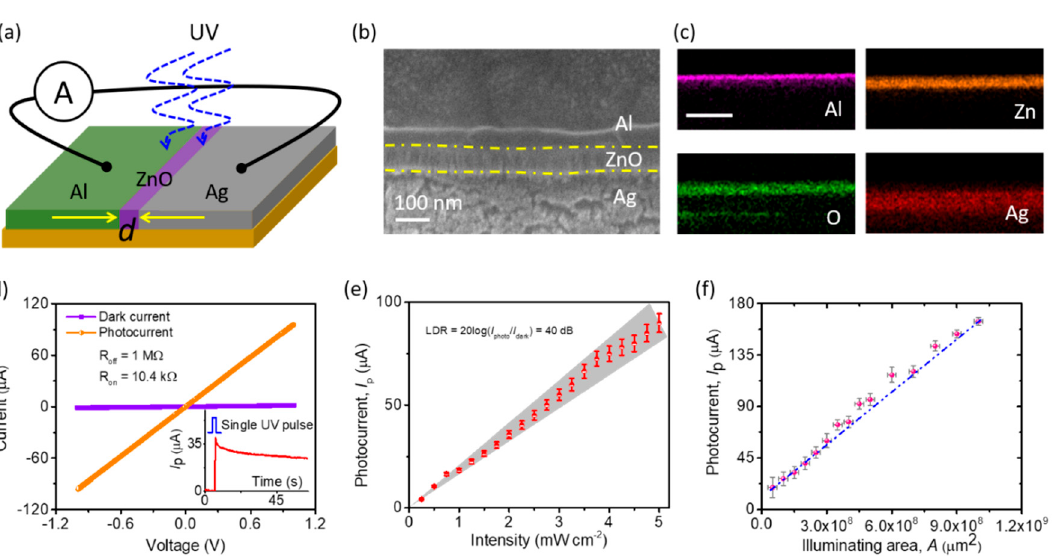
Figure 2. Schematic and device characterization. ( a ) Device schematic, ( b ) planar-view SEM of the ZnO nanofin sandwiched between Al and Ag thin film, ( c ) corresponding elemental distribution of the Al, Zn, O, and Ag from energy-dispersive X-ray spectroscopy (EDS) measurements, clockwise. The scale bar is 1 µ m. ( d ) Current–voltage characteristics of the device under dark and with di ff erent UV illumination, showing photocurrent generation. The inset of ( d ) shows the device retention measurements at + 0.6 V, after applying a single UV pulse. ( e ) The change in photocurrent ( I p ) as a function of light intensity. ( f ) The photocurrent generation due to di ff erent areas.